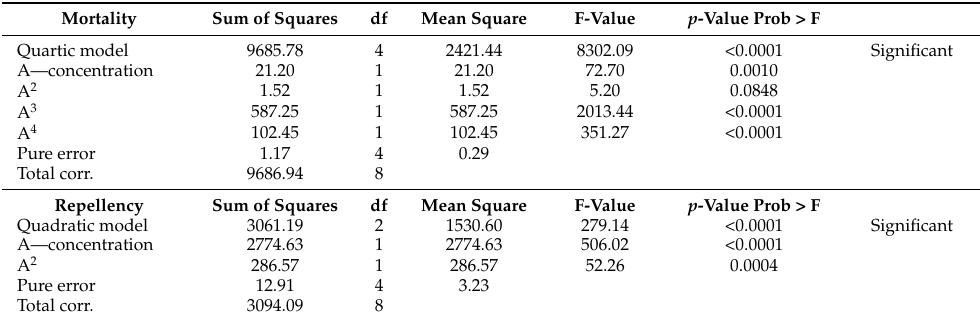
Table 3. ANOVA test for response surface quartic model (termite mortality) and for response surface quadratic model